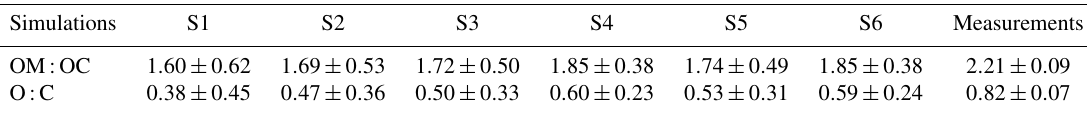
Figure 4. Daily evolution of the ratios OM:OC (a) and O:C (b) from 1 January to 2 April 2014 at Ersa. Table 7. Daily averages of OM:OC and O:C ratios at Ersa during winter 2014 for the different simulations. The average measured OM:OC ratio is 2.21 and the average measured O:C ratio is 0.82.